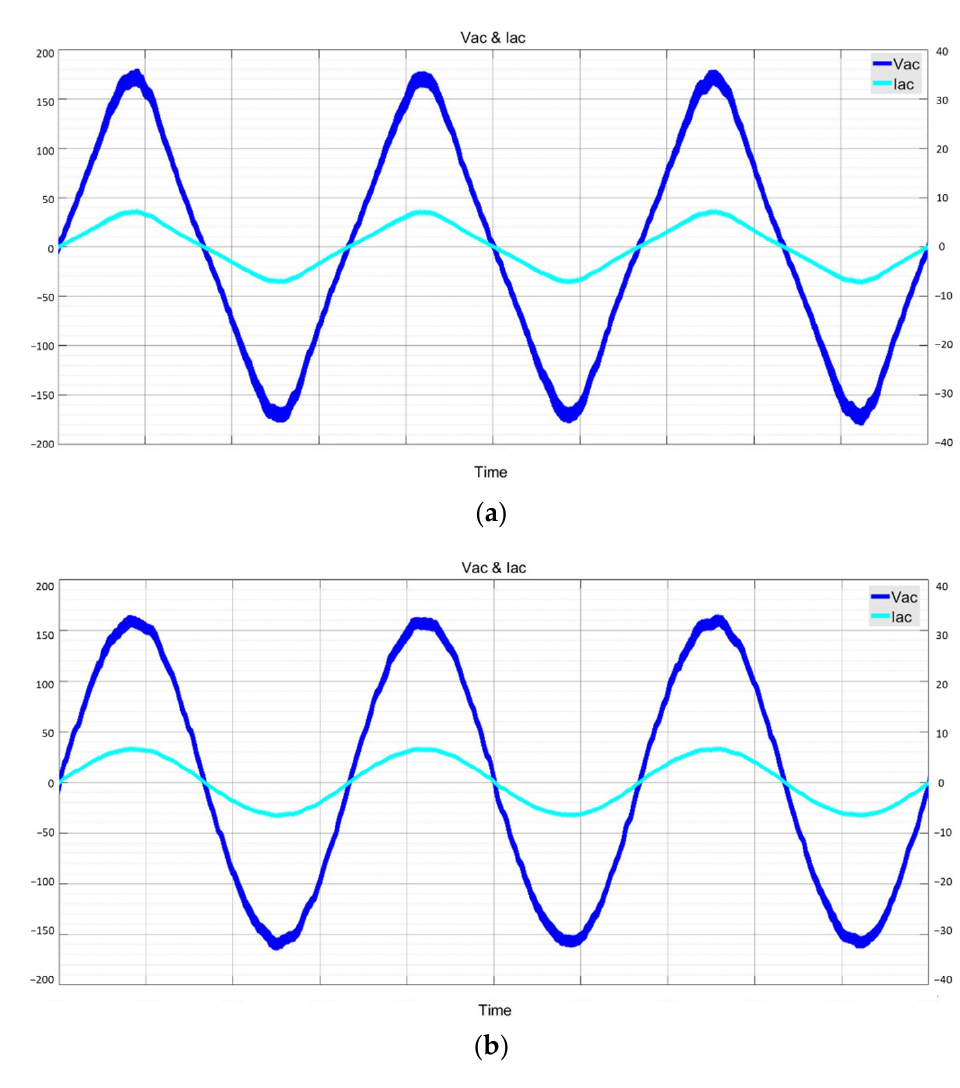
Figure 16. The simulation results (500 W) of the voltage and current output waveforms when using ( a ) the traditional SPWM control and ( b ) modified SPWM control.